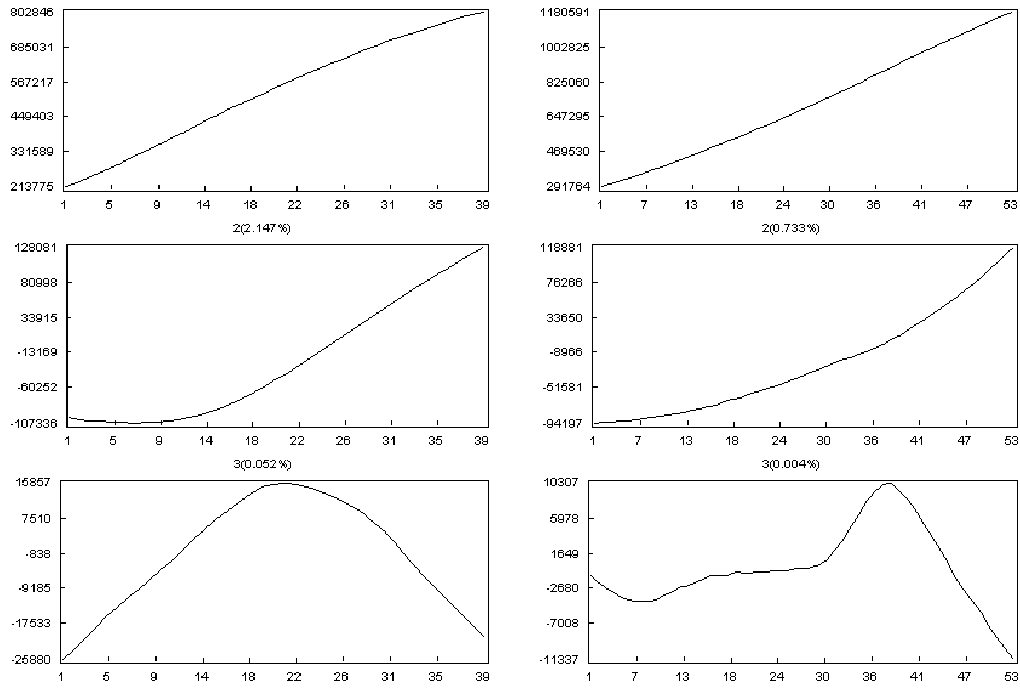
Figure 17. Principal components related to the first three eigentriples.